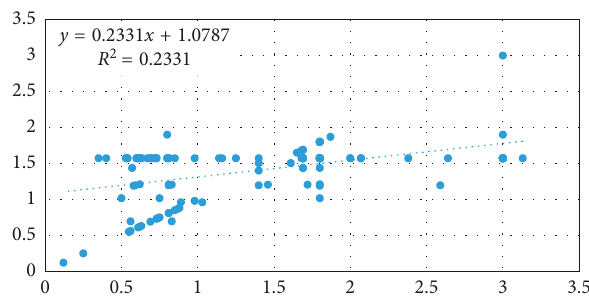
Figure 5: U-opaque prediction using the latitude and longitude of the building.